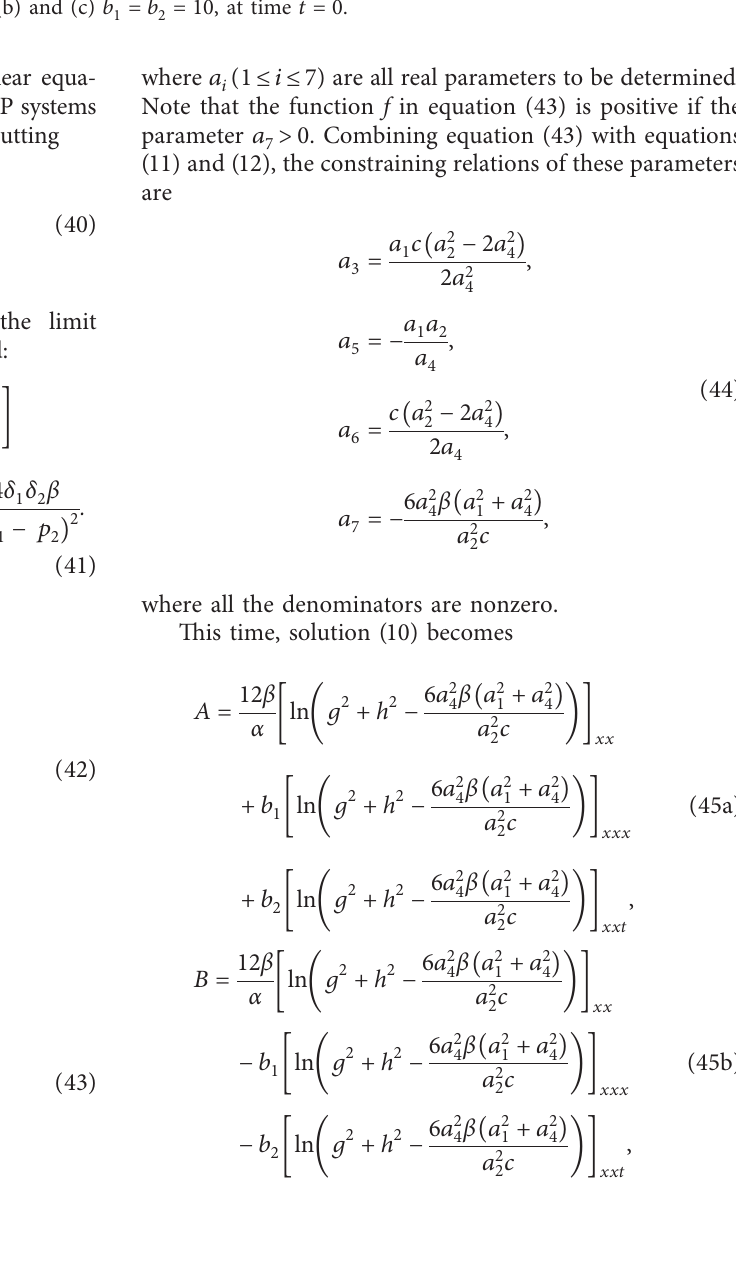
� b � 0 and (b) and (c) b and b are (a) b 1 2 1 2